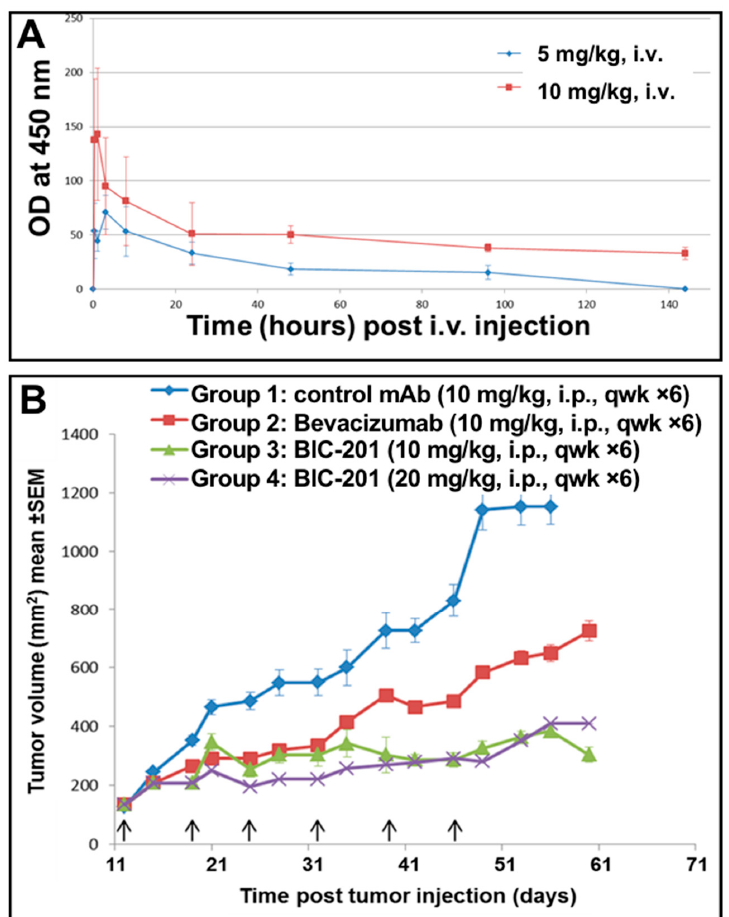
Figure 13. Mouse studies of BIC101 and BIC201. ( A ) Mouse blood pharmacokinetics of BIC101 and BIC201. Mice were injected with a single dose of 5 mg/kg of BIC101 (blue diamonds) or 10 mg/kg of BIC201 (red squares). The concentration of the bsAbs in the mice sera was evaluated by ELISA using human Ang2 as an antigen; ( B ) Bispecific anti Ang-2–anti VEGF BIC201 inhibits the growth of Colo205 tumor xenografts compared to the monotherapy of bevacizumab. The anti CD20 therapeutic mAb rituximab was used as isotype control (group 1). Antibodies were administered i.p. (n = 10 mice per group). Treatment started at day of randomization (study day 12) with 10 mg/kg or 20 mg/kg once weekly for a total of 6 injections (indicated by vertical arrows).